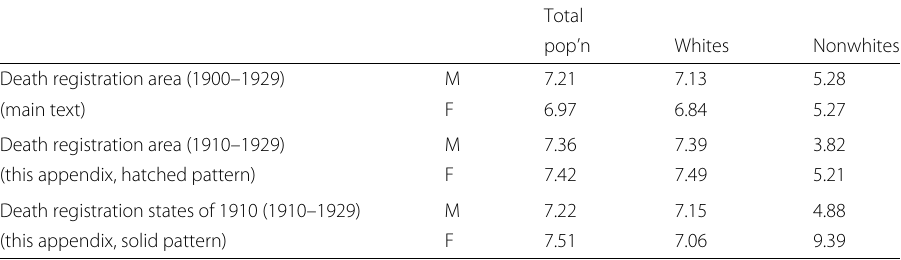
Table 5 Width of projection fan in 1940 (in years of life expectancy), for all eighteen population × sex × panel